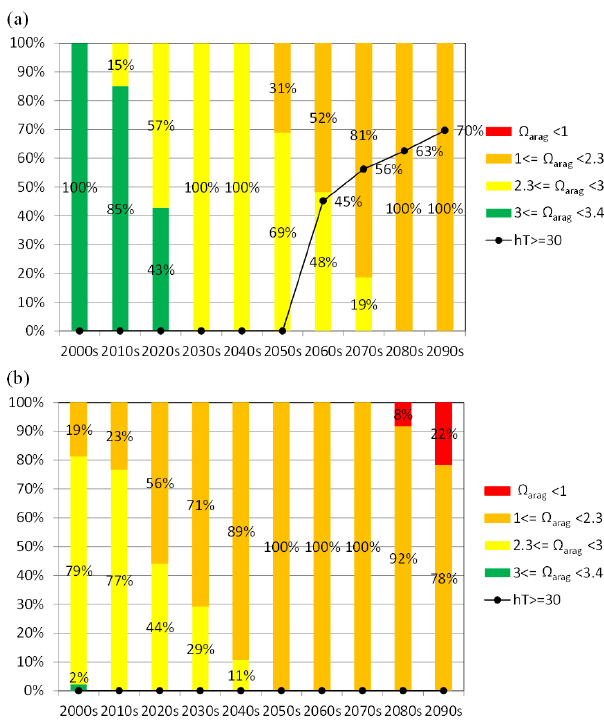
Fig. 4. Projected temporal changes in the surface area of coral habitats where the monthly-mean SST in the coldest months for 2000s–2090s is (a) ≥ 18 ◦ C (tropical/subtropical coral community) and (b) 10–18 ◦ C (temperate coral community), respectively. Colors represent the domain of (cid:127) arag < 1 (in red), 1 ≤ (cid:127) arag < 2.3 (in or- ange), 2.3 ≤ (cid:127) arag < 3 (in yellow), and 3 ≤ (cid:127) arag < 3.4 (in green), respectively. Black lines show projected ratio of the surface area where the SST during the hottest months is ≥ 30 ◦ C in each do- main.